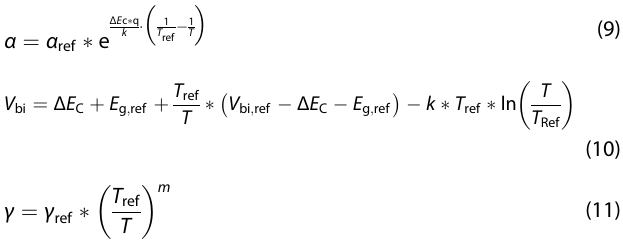
Fig. 4 Determining the shunt behaviour with irradiance and activation energy. a Variation of shunt resistance with irradiance for different modules. The dotted lines show the power relation fi t for each of the modules. The inset table shows R sh,ref and fi t parameter u for each of the modules. b variation of V oc with temperature ( T ) for the different modules. The inset: The intercept of the V oc vs. T line at 0 K representing E a . ( V oc of the modules are divided by the number of cells in series to obtain the V oc of the resistance for all cells, single cell shunt resistance can be obtained by multiplying the N s to the module shunt resistance. The N p measurement of shunt resistance at different incidence irradiance shows that it varies non-linearly with irradiance. We propose to use Eq. (7) to represent the shunt resistance variation for CIGS technology. R sh ref is the shunt resistance at reference irradiance ð G Þ of 1000 W m − 2 and G is the incident irradiance: ref